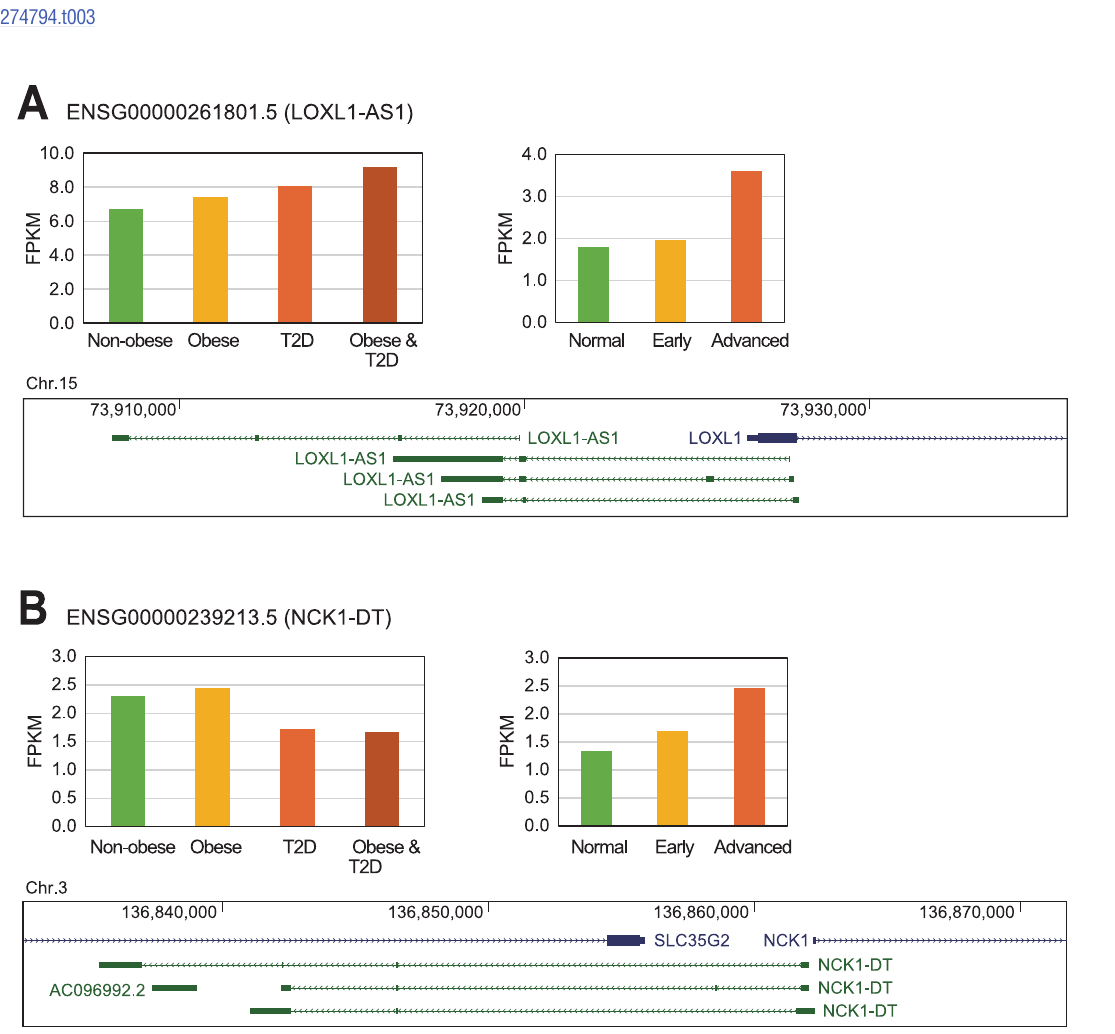
Fig 4. Commonly dysregulated lncRNAs identified in both myotube and kidney samples from patients with diabetes. Of the significantly altered lncRNAs from both the myotube and kidney tissues of the patients with diabetes, only (A) LOXL1-AS1 and (B) NCK1-DT were identified in both tissues and are shown here. The graphs describe the FPKM value for each lncRNA in each sample set and the genomic context for each is shown below. Blue lines represent protein-coding genes, green lines lncRNA genes, and red lines small non-coding RNA